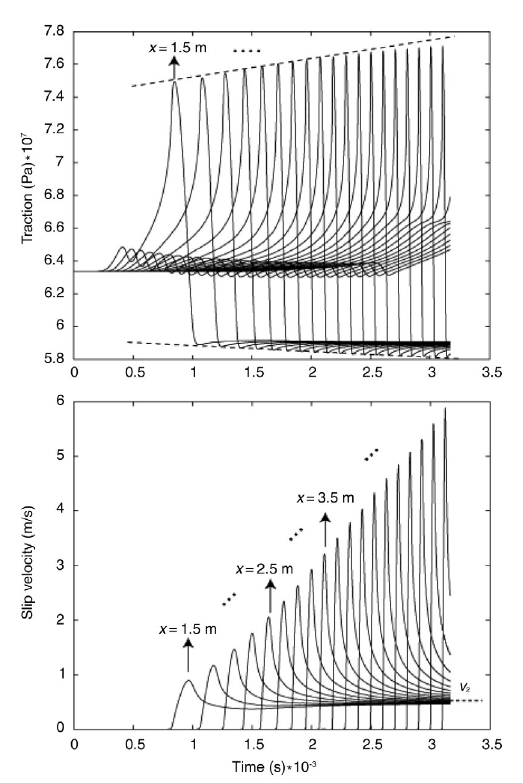
Fig. 2. Temporal evolution of dynamic traction and slip velocity for several selected points located at dif- ferent distances from the nucleation. Dashed lines represent the envelopes of τ u eq and τ f eq values. The constitutive parameters are the same used for the pre- vious figure and are listed in table